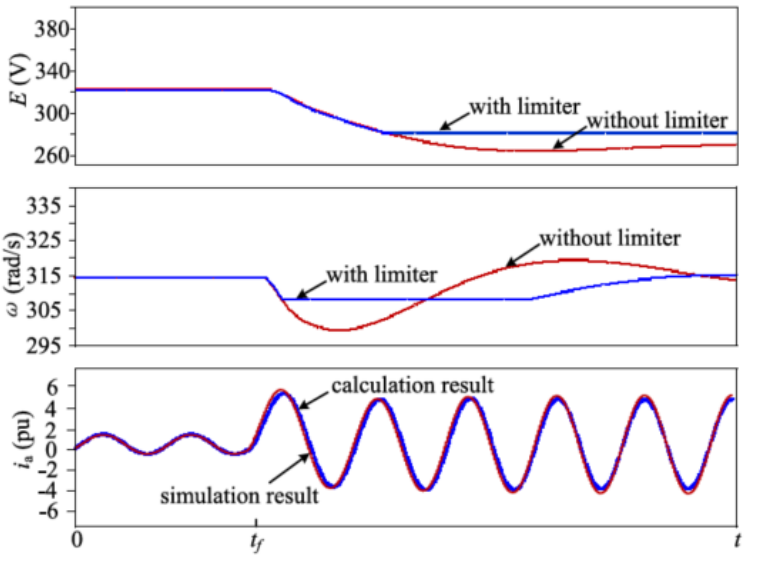
Figure 3. Magnitude of the reference voltage ( upper ), reference angular frequency ( middle ), and phase a fault current ( bottom ) of droop-controlled inverter with or without droop limiters when subjected to symmetrical faults at 𝑡 (cid:3033) (PCC voltage dip to 70% of the rated value) [34].